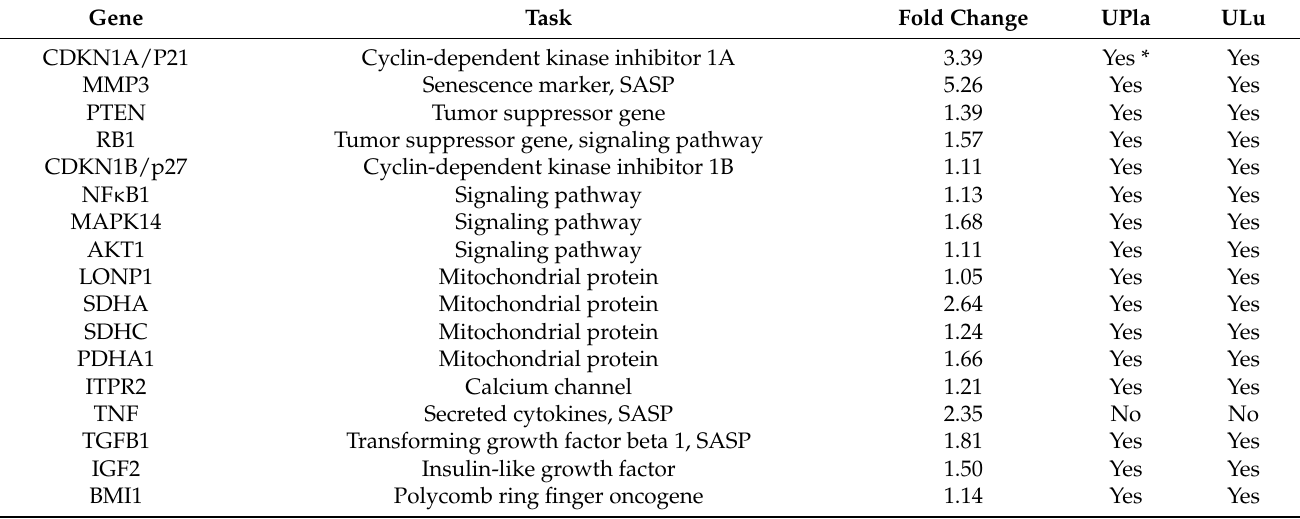
Table 2. Genes significantly upregulated by H 2 O 2 in HepG2